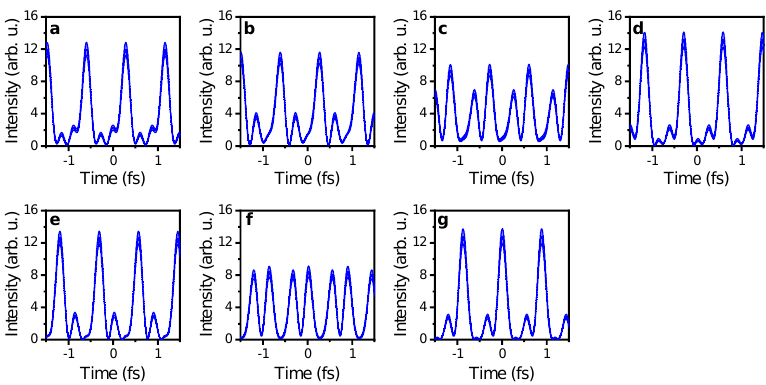
Figure 6. Reconstructed attosecond pulses for a phase scan using the phase shifter PS 2 . ( a – g ) Evolu- tion of the intensity profile of the attosecond pulses in the attosecond pulse train generated with the harmonic comb containing the harmonics H 7 , H 8 , H 9 , and H 10 of the seed laser, for different values of the phase shifter(PS 2 ), corresponding to Figure 5a,h(a), Figure 5b,i(b), Figure 5c,j(c), Figure 5d,k(d), Figure 5e,l(e), Figure 5f,m(f), and Figure 5g,n(g). The error in the reconstruction is indicated as a shaded region in each panel.